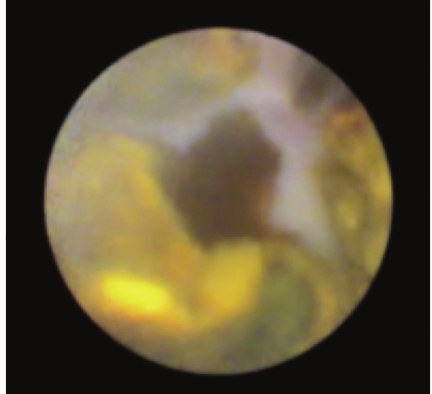
Figure 2: Broken bile duct large stone after EHL